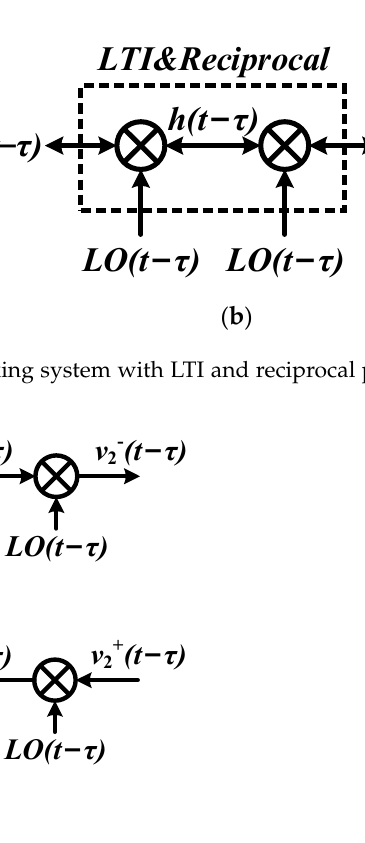
Figure 3. Doubly square-wave mixing system with time delay in the internal node: ( a ) forward direction; ( b ) reverse direction.